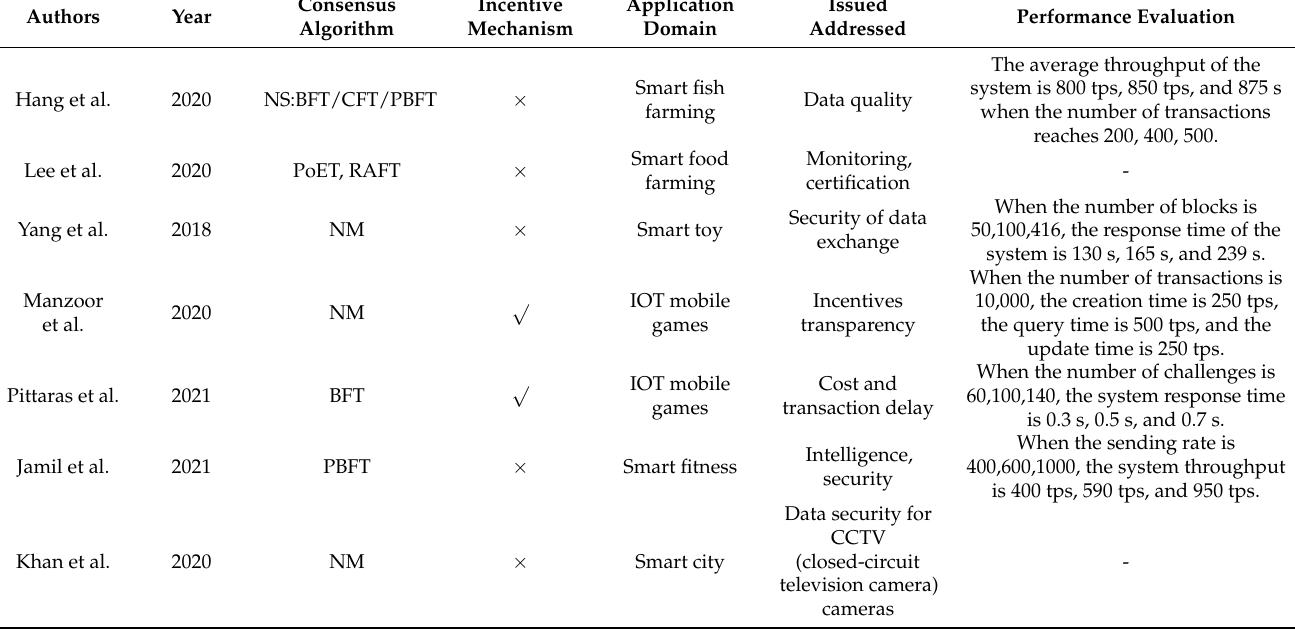
Table 4. Differences between schemes of Sections 4.2–4.5 (NS: mention but not specify, NM: not mentioned).